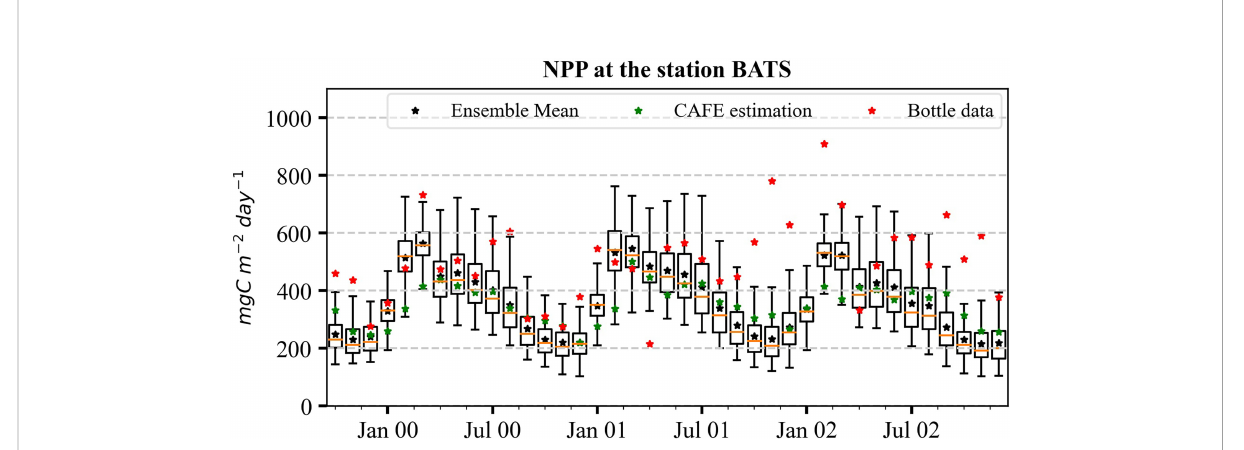
FIGURE 12 Comparison of monthly mean simulated NPP of EXP State_EP , satellite-derived NPP based on SeaWiFS satellite and in situ bottle data. The box denotes the lower to upper quartile values of ensemble members. The horizontal line on the box is the median of the ensemble. The whiskers show the range of the